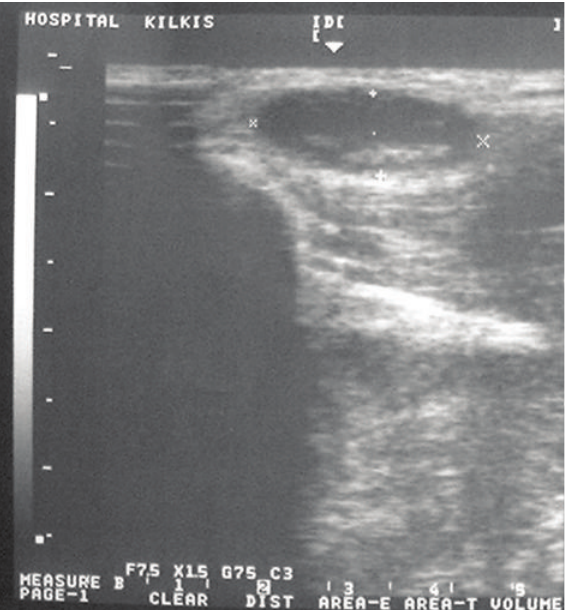
Figure 2: The (ECHO) ultrasonic scan of the area showing a sizeable infrasonic formation with distinct boundaries.